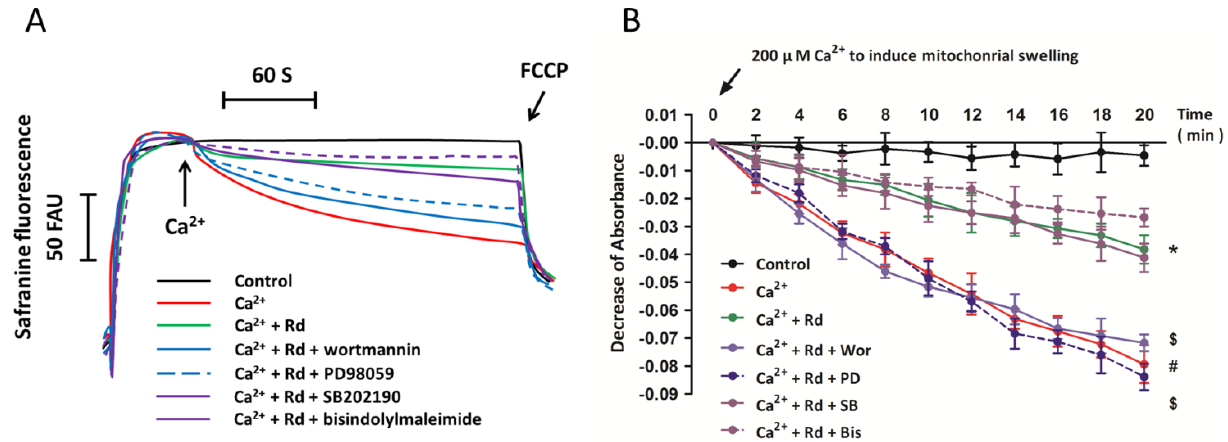
Figure 6. Effects of protein kinase inhibitors on mitochondrial membrane potential dissipation and swelling after Ca 2+ treatment in Rd pretreated spinal cord mitochondria. Isolated spinal cord mitochondria (0.5 mg protein/mL supported by succinate) were pretreated with 1 μM wortmannin (Wor, PI K inhibitor), 50 nM bisindolylmaleimide 3 (Bis, PKC inhibitor), 10 μM PD98059 (PD, ERK inhibitor), or 10 μM SB202190 (SB, p38 inhibitor) in the presence or absence of 10 μM Rd for 10 min before the incubation with 30 μM Ca 2+ . ( A ) The mitochondrial membrane potential was measured up to 300 s. Controls were performed in the absence of Ca 2+ , and 1 μM FCCP was added to induce maximal depolarization at the end of the measurements. Traces are representative of three independent experiments performed in duplicate and were expressed as fluorescence arbitrary units (FAU); ( B ) Mitochondrial swelling was examined by monitoring the absorbance at 540 nm induced by 200 μM Ca 2+ . The control was measured without Ca 2+ . The data were represented as means ± SD from five experiments. # p < 0.05 vs.